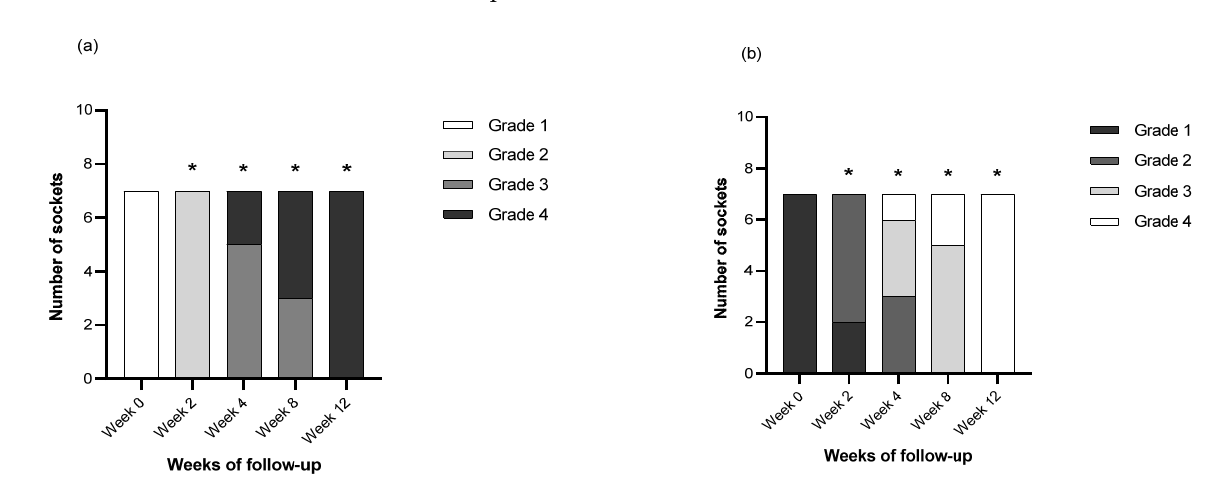
Figure 8. The number of sockets following characteristics of surgical site margin ( a ) and characteristic of new alveolar bone formation ( b ) in each week of follow-up are represented with bar plots. An asterisk on top of a bar indicates a statistically significant difference at a p -value of 0.05. Table 2. Comparison of radiographs following changes in lamina dura around socket (Criteria A) and characteristic of new alveolar bone formation following changes in radiodensity within socket (Criteria B) between the day of operation and 2nd, 4th, 8th and 12th postoperative weeks.